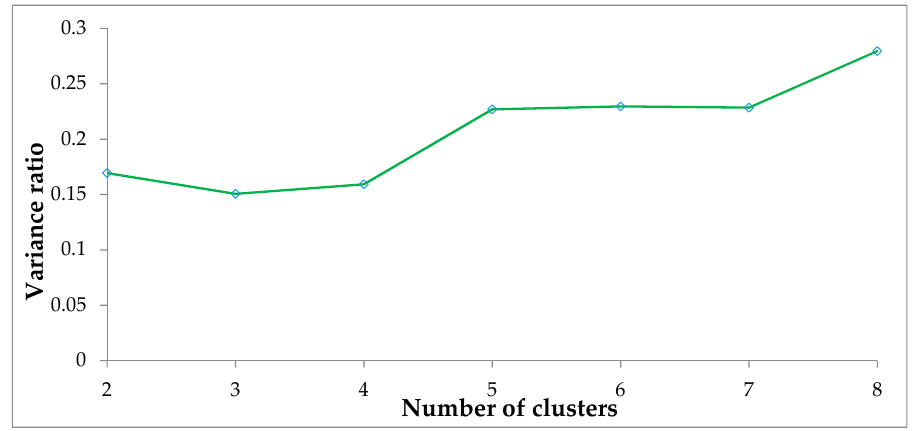
Number of clusters